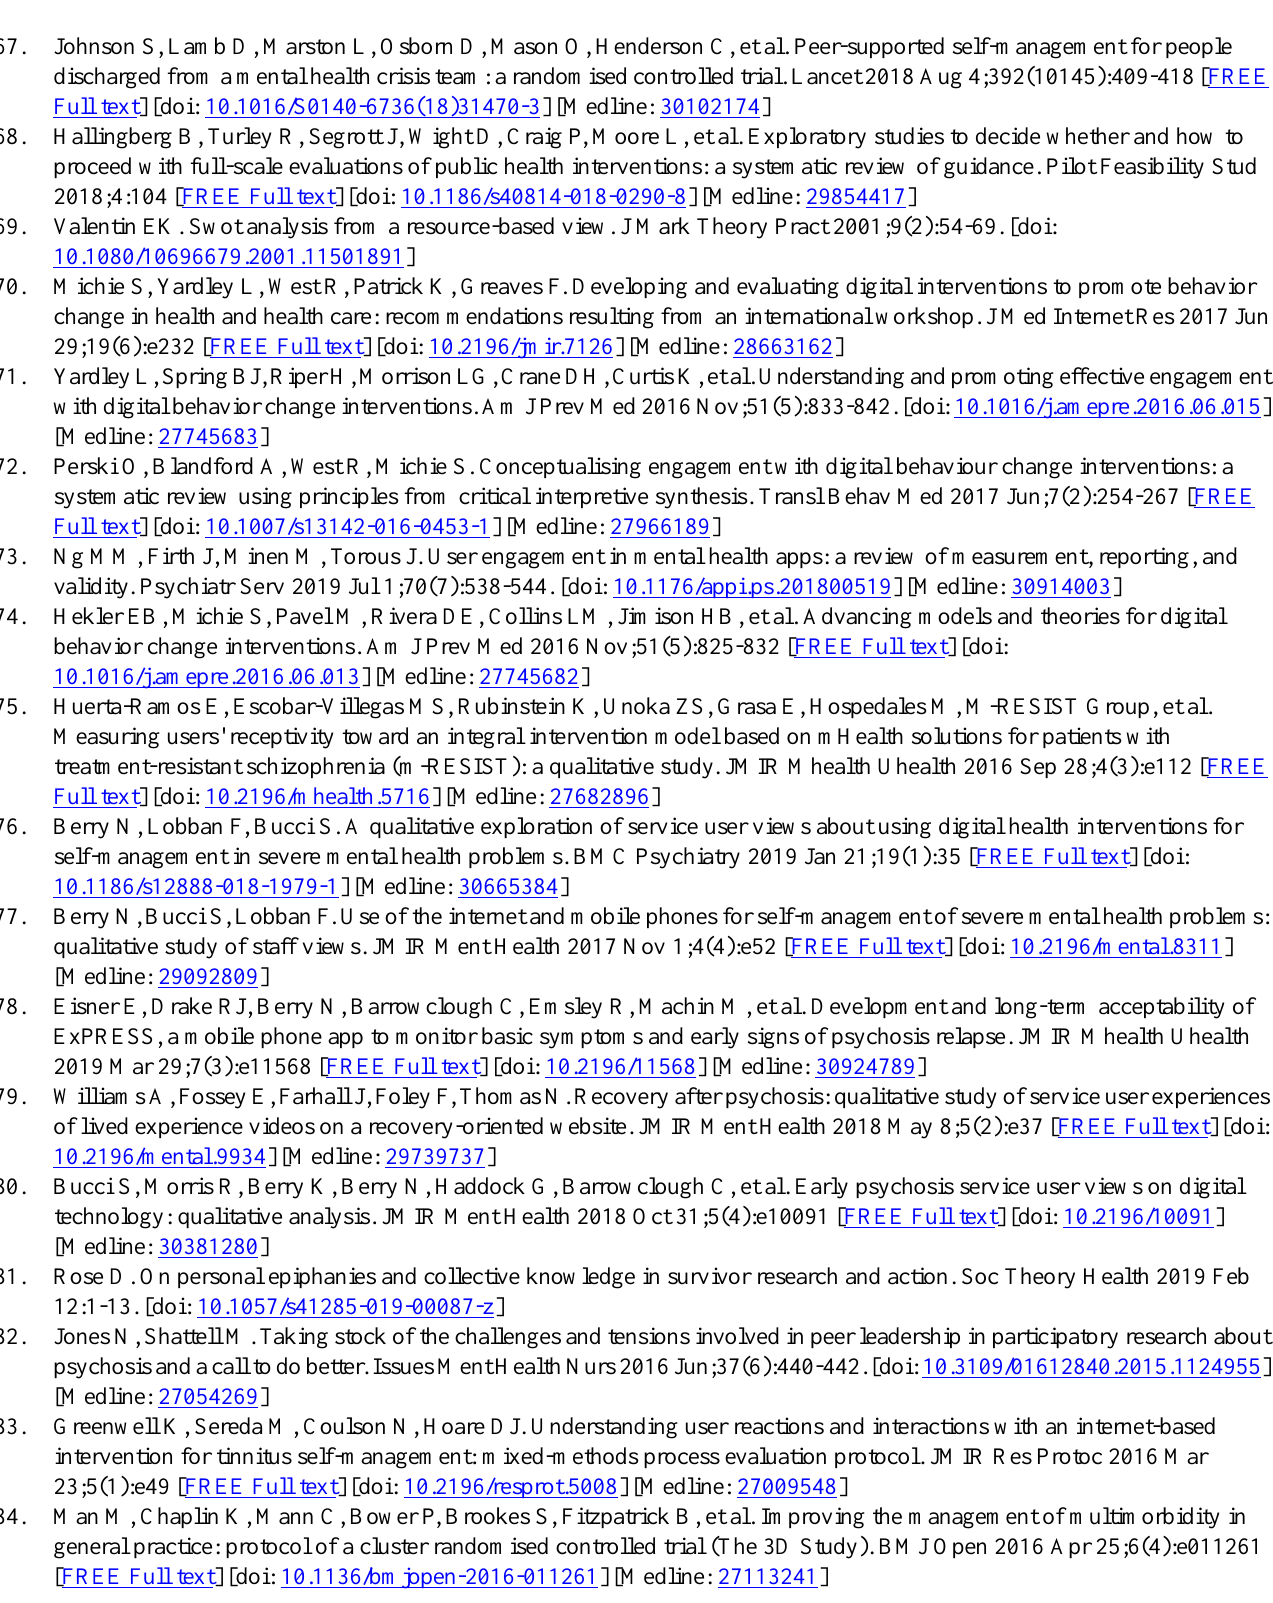
c-RCT: cluster randomized controlled trial EMA: ecological momentary assessment EMPOWER: Early signs Monitoring to Prevent relapse in psychosis and prOmote Well-being, Engagement, and